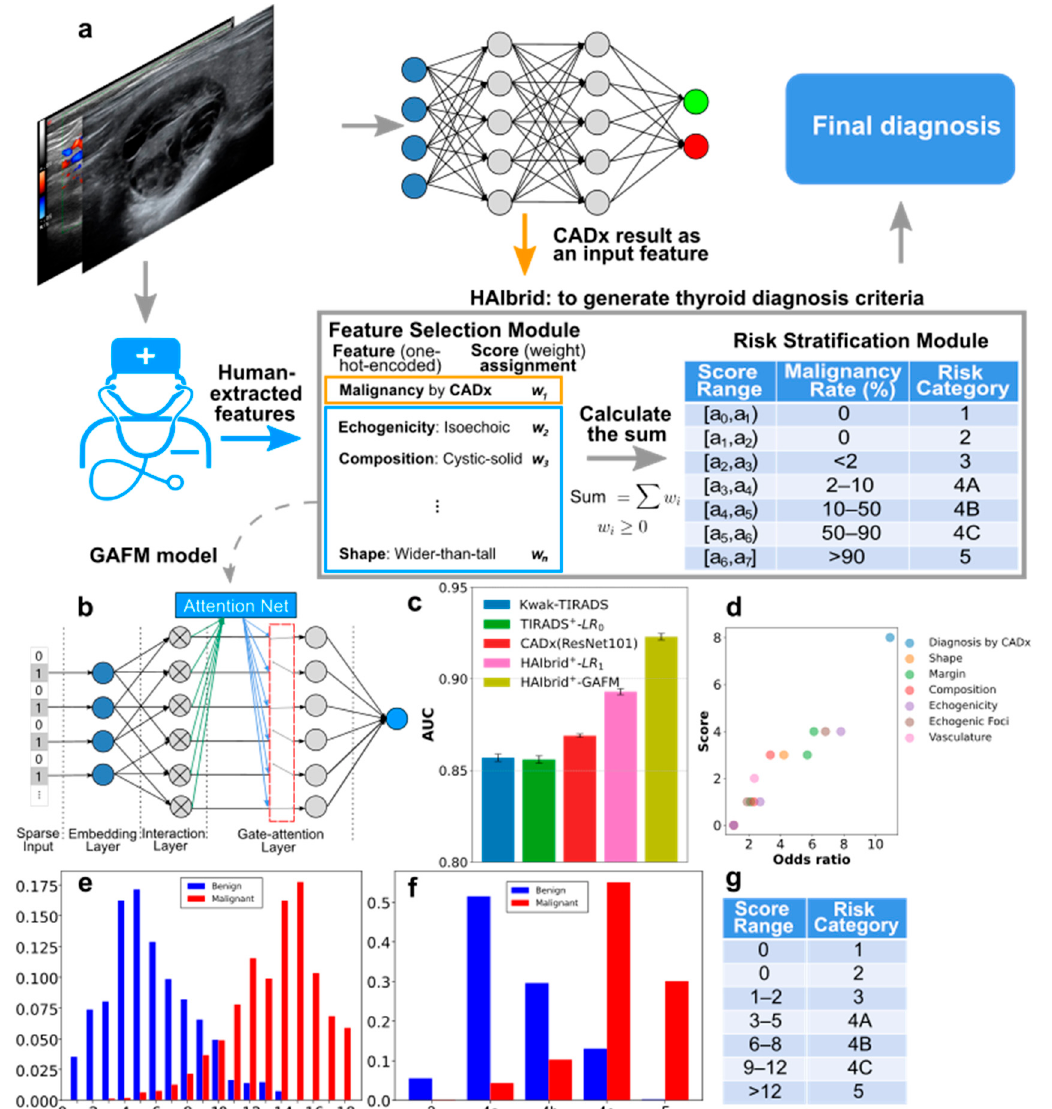
Figure 1. Our proposed HAIbrid method to establish CNN-boosted human-understandable thyroid diagnostic criteria and the corresponding results. ( a ) Scheme depicting the workflow: first, radiolo- gists extract features from the ultrasound images and a convolutional neural network of arbitrary architectural design produces primary diagnosis results as a separate feature to construct a candidate feature set and then use a feature selection module that optimizes feature weights to generate the thyroid diagnostic criteria and finally return the diagnosis. The risk stratification module ensures that the malignancy rate for each risk category is within the corresponding specified range. ( b ) The neural network architecture of our proposed GAFM model consists of an input layer, embedding layer and interaction layer identical to an AFM, with an additional gate mechanism to filter out minimally relevant second-order interacting features. ( c ) Bar plot of the mean AUC values together with the corresponding standard deviations from 10-fold feature-stratified cross-validation experiments for diagnosing thyroid nodules using different methods. ( d ) The correlation between the assigned score of each selected feature by the GAFM model and the corresponding odds ratio. ( e ) The probability density functions of HAIbrid-TIRADS scores computed based on GAFM model for benign and malignant samples. ( f ) The distributions of samples according to our risk classifications. ( g ) Table of score ranges for risk classifications.